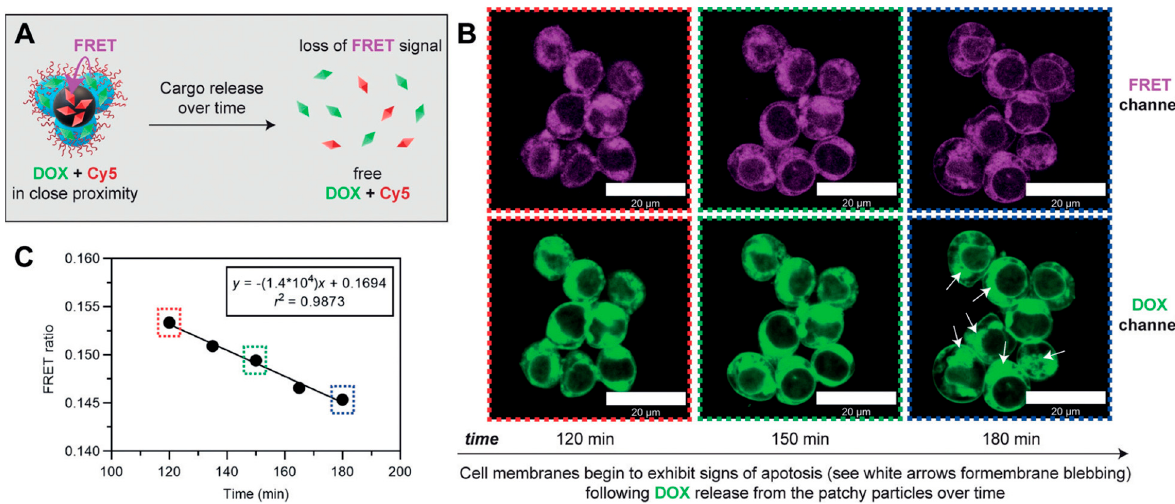
Figure 15. ( A ) Illustration of FRET mechanism of DOX/Cy5 co-loaded patchy particle. ( B ) Confocal images of MCF-7 cells at 120, 150, and 180 min incubation with DOX/Cy5 co-loaded patchy particles. ( C ) Changes in FRET ratio over time. Reproduced with permission from ref. [46]. Copyright 2019, Wiley-VCH Verlag GmbH & Co. KGaA, Weinheim, Germany.